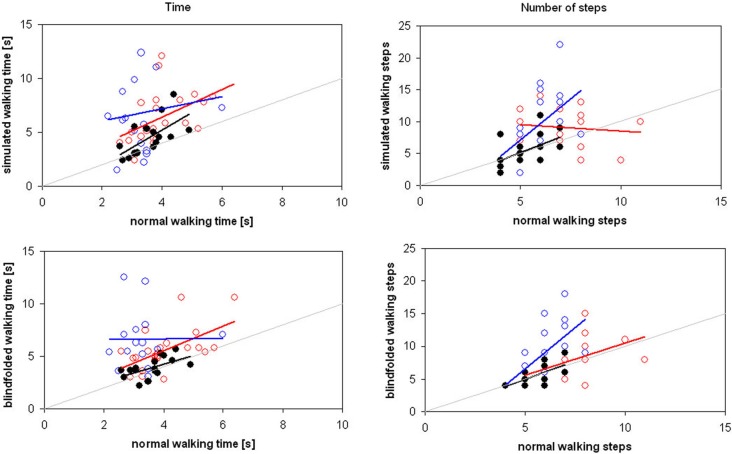
Time (on the left) and number of steps (on the right) spent for covering the distances of 2 and 3 m in simulated (above) and blindfolded (below) walking by adults (black filled circles), children with typical development (blue empty circles) and children with cerebral palsy (red empty circles). Regression lines are reported in the same color of relevant data, whereas the gray line is the theoretical line of equality.